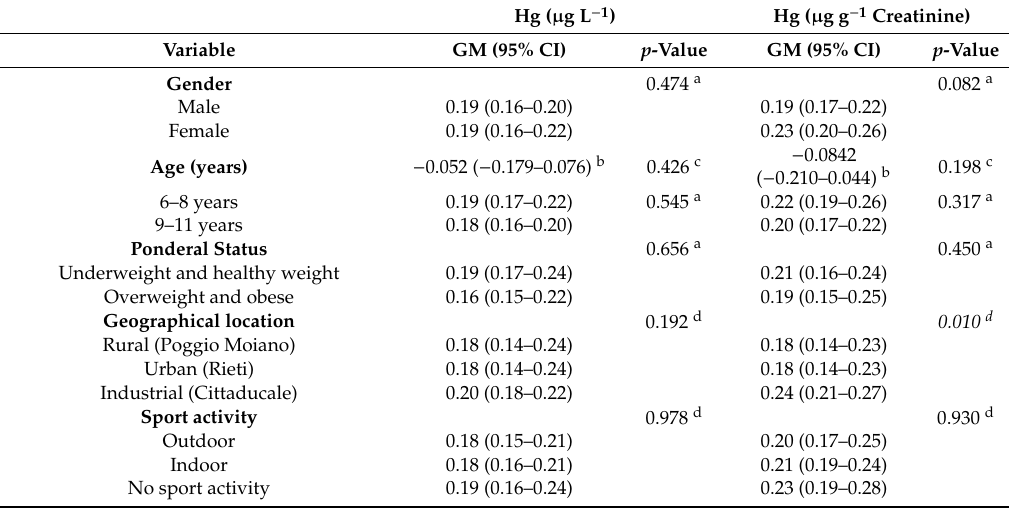
Table 3. Association between urinary mercury (Hg) level and sociodemographic/food consumption characteristics of children.